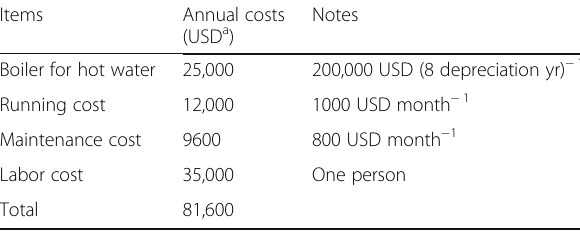
Table 2 Cost of the boiler in Route 1 Items